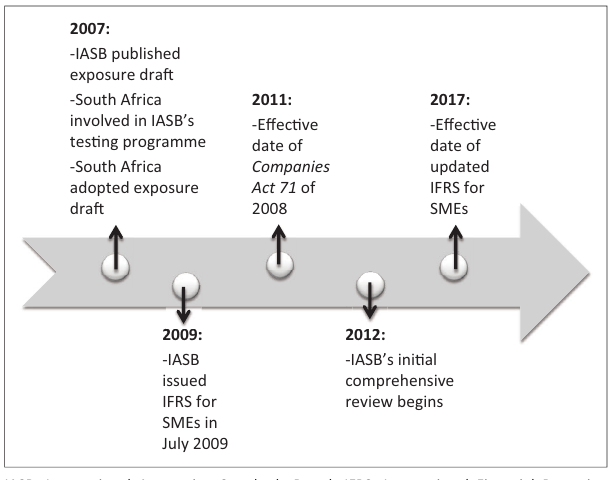
FIGURE 1: Timeline illustrating the development of IFRS for SMES by the IASB and the adoption of IFRS for SMEs in South